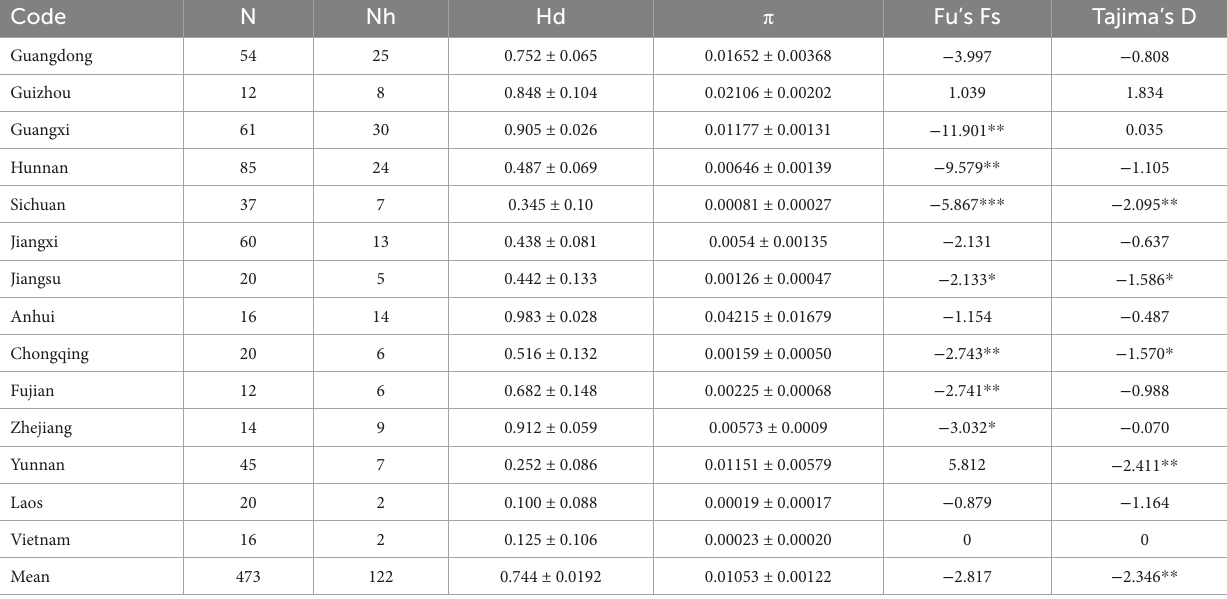
Samples sizes (N), number of haplotypes (Nh), haplotype diversity (Hd), nucleotide diversity ( π ), Fu’s Fs and Tajima’s D are showed. Asterisks represent level of statistical significance: * p < 0.05; ** p <